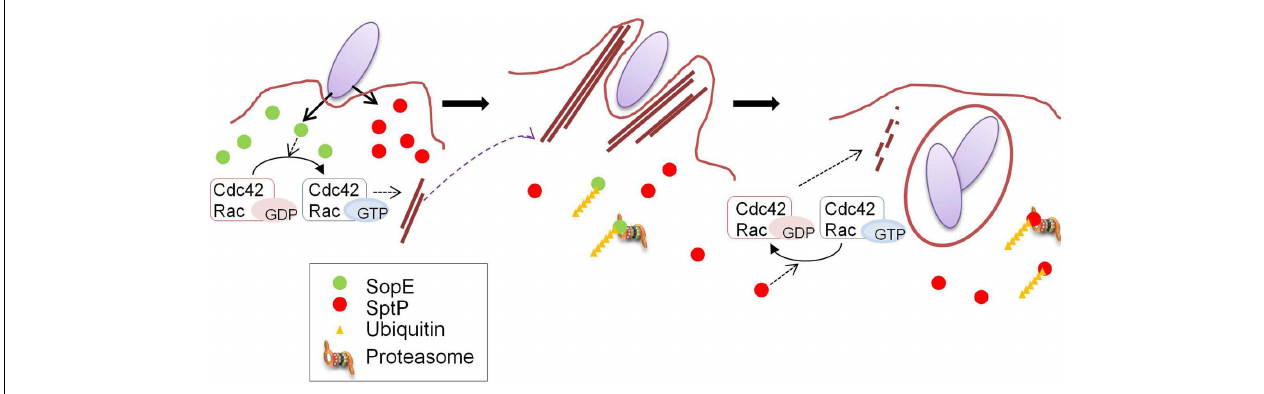
FIGURE 2 | Coordination of the functions of SopE and SptP. A model for the temporal regulation of SopE and SptP functions. SopE and SptP are delivered in equivalent amounts via the Salmonella T3SS upon infection, and SopE dominantly activates Rho GTPases Cdc42 and Rac as a GEF (left panel), resulting in bacterial uptake by profuse membrane ruffling (middle